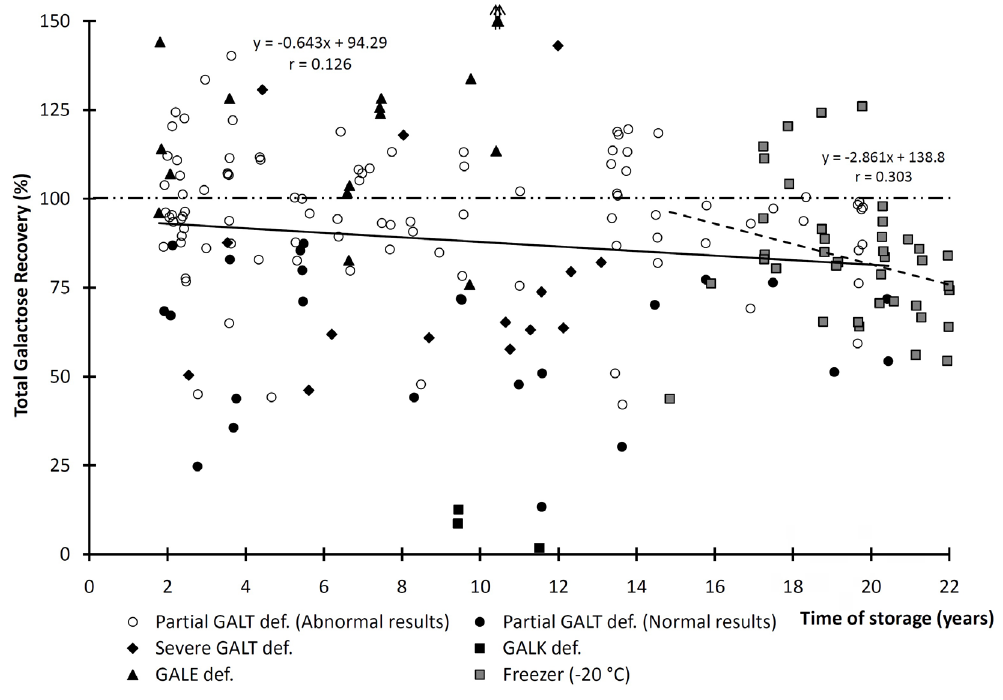
Figure 6. TGal recovery at retesting in residual DBS specimens stored in two different storage conditions. Note: References ○, ●, ♦, ■ and ▲ correspond to residual DBS specimens stored at room temperature. The legend Abnormal/Normal results indicate the qualitative results interpretation at retesting. GALT: Galactose-1-phosphate uridyltransferase, GALK: Galactokinase, GALE: UDP-Galactose 4-epimerase.